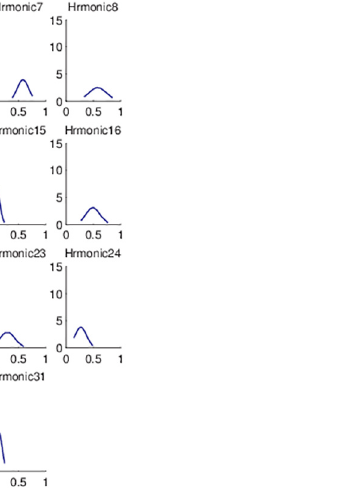
Fig 6. Normalized distribution of